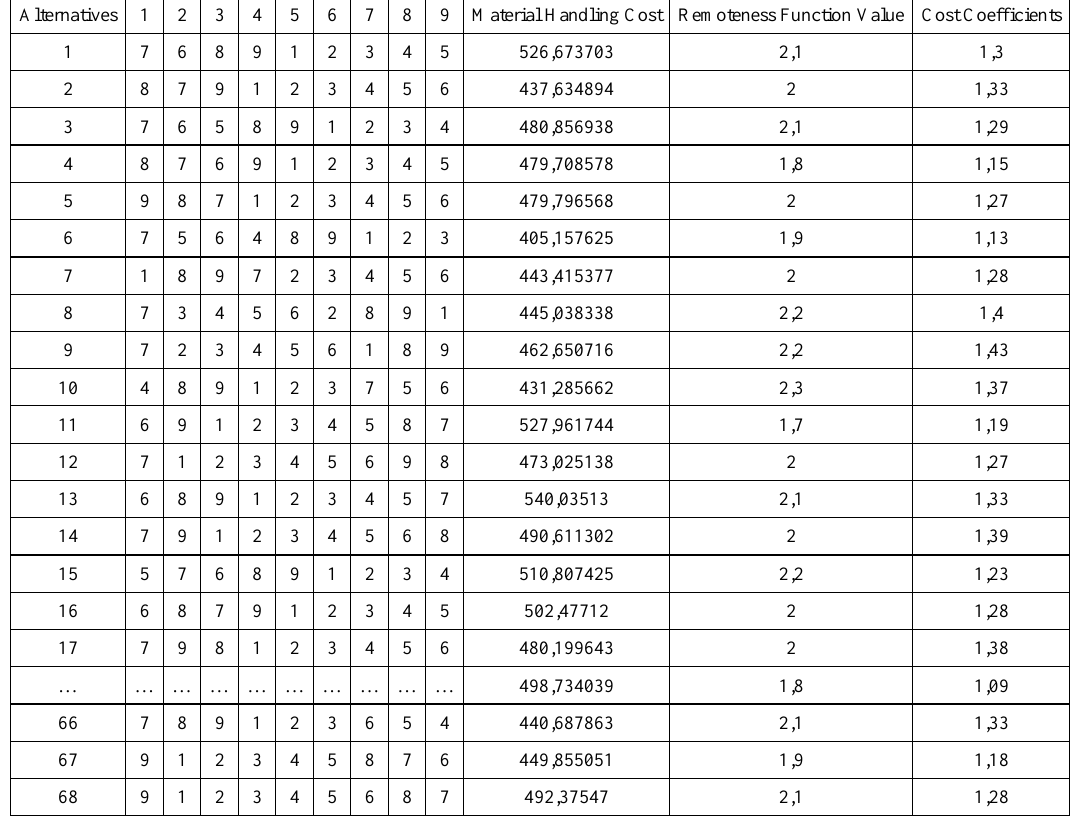
Table 5. Calculated of the objective function